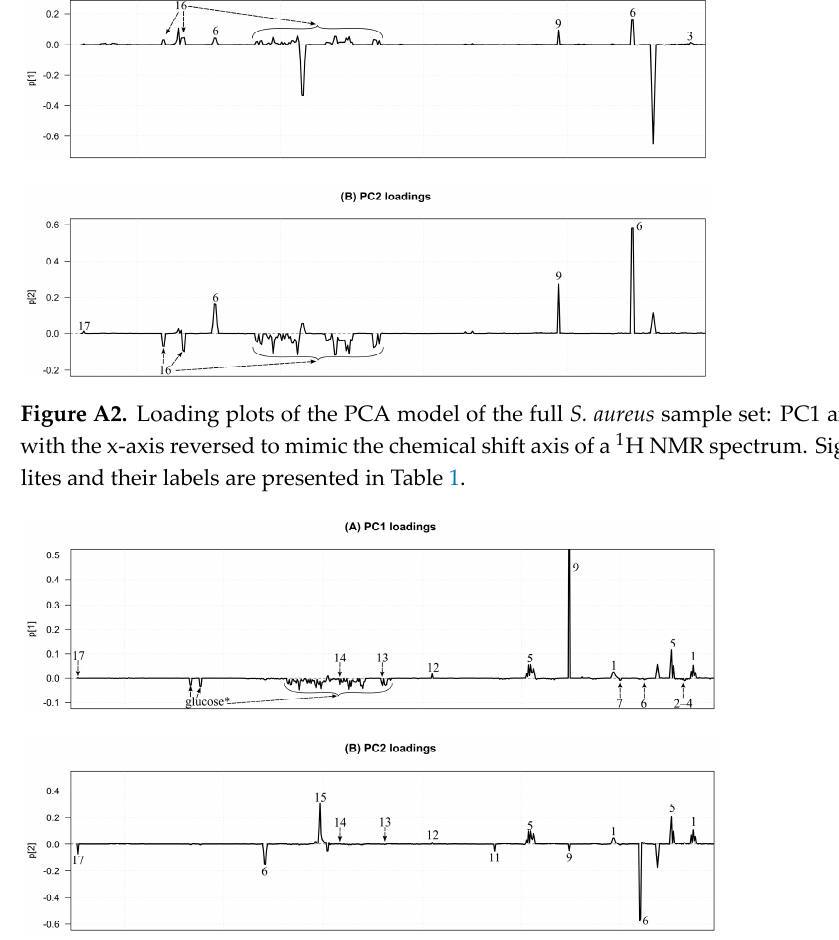
Figure A3. Loading plots of the PCA model of the full fecal batch culture sample set: ( A ) PC1 and ( B ) PC2 loadings with the x-axis reversed to mimic the chemical shift axis of a 1 H NMR spectrum. Significant metabolites and their labels are presented in Table 1. * Glucose marked in addition to the significant metabolites due to its prevalence in the graph.